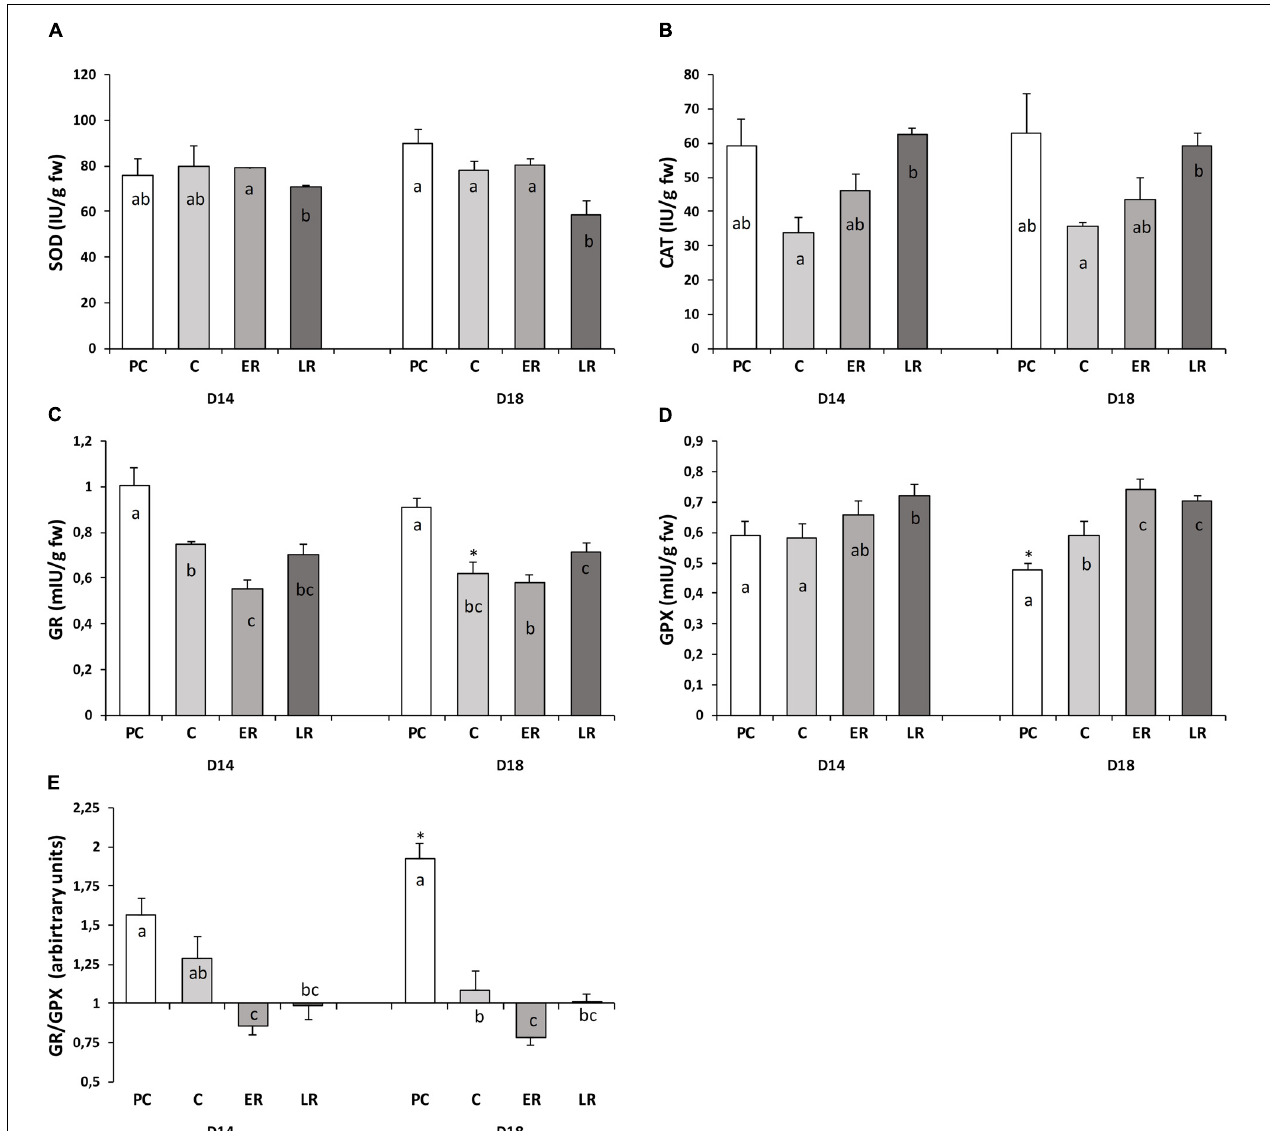
FIGURE 3 | Activity of redox-associated enzymes ( A : SOD, B : CAT, C : GR, D : GPX, and E : the GR/GPX ratio) throughout the study period. Values are mean ± standard error of the mean. PRE-COLD, data obtained from day 30 of the pre-cold period at 22 ◦ C; COLD, data obtained after 50 days at 14 ◦ C (day 80); EARLY and LATE RECOVERY, data obtained 7 and 35 days after temperature restoration to 22 ◦ C (day 87 and 115), respectively. Lowercase letters (a–c) indicate significant differences between the periods within each diet ( p < 0.05, one-way ANOVA). Symbols ( ∗ ) indicate significant differences between diets at each period ( ∗ p < 0.05 vs. D14; Student’s t